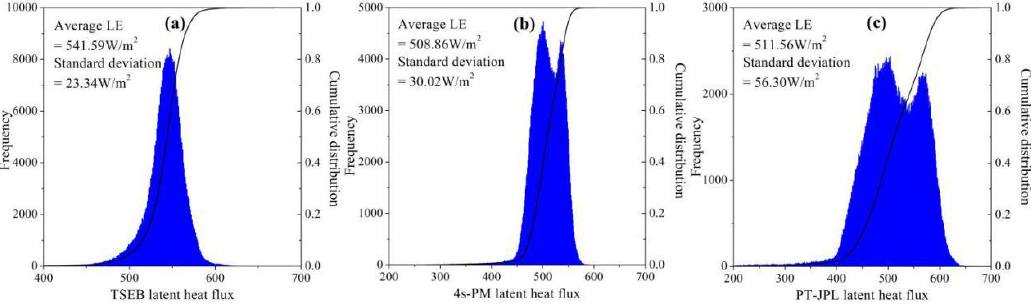
Figure 8. Histogram of the LE on 19 August of 2014 for different modes: ( a ) TSEB, ( b ) 4s-PM, and ( c ) PT-JPL.